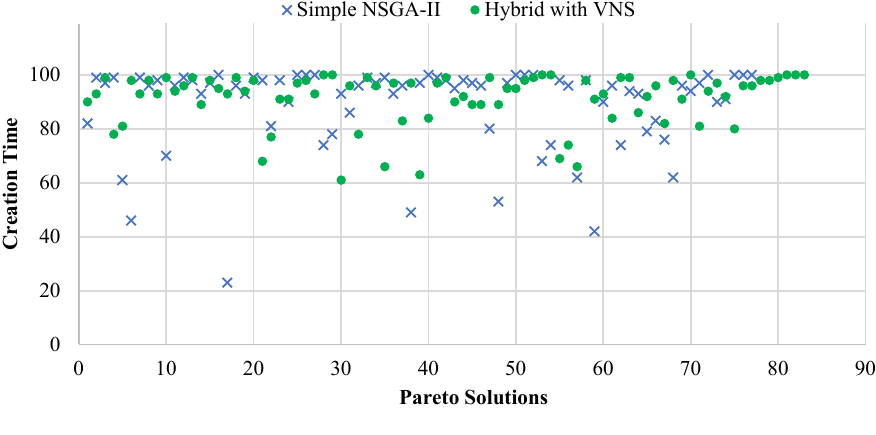
Fig. 4. Convergence process of Pareto-optimal solutions for various